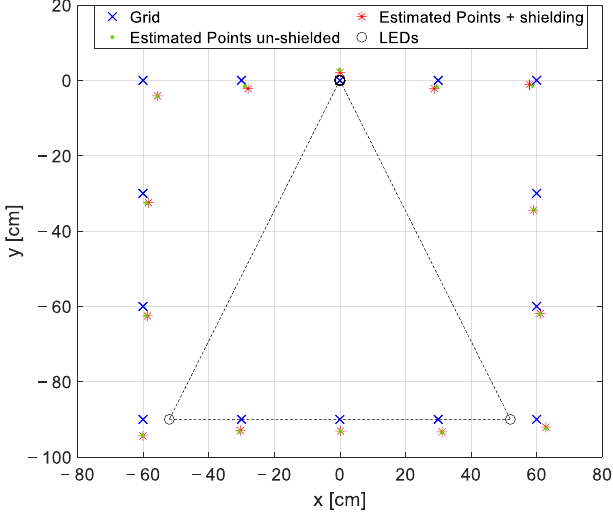
Figure 11. Qualitative grid representation of the estimated coordinates for the test performed shielding the measurement area and considering just the 14 perimeter points: in blue the ‘true positions’ of the grid points, in red and green, respectively, the coordinates estimated shielding and un-shielding the measurement area.